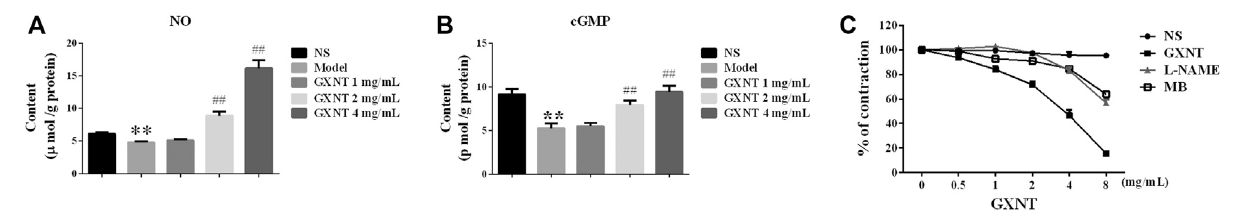
FIGURE 3 | GXNT promoted nitric oxide (NO) production in endothelium-intact vascular rings and further activated the soluble guanylate cyclase (sGC) – cyclic guanosine monophosphate (cGMP) expression. NO (A) and cGMP (B) contents in endothelium-intact vascular rings after GXNT treatment. After precontraction with 10 − 6 M PE, rings with intact endothelium were incubated with 1, 2, and 4 mg/ml GXNT for 45 min and immediately collected for homogenization. Before testing with an ELISAkit, homogenate supernatants werecentrifuged at3,000 rpmfor10 min. Themodel indicates treatment withPEwithoutGXNT,NSindicates treatmentwith onlynormalsaline. (C) ImpactofGXNTonNOsynthesisandGCinendothelium-intactvascularrings.AorticringswerepreincubatedwiththeNOSsynthaseinhibitorNw- nitro-L-argininemethyl ester(L-NAME) (10 − 4 M)and guanylate cyclaseinhibitor methylthionine chloride (MB)(10 − 5 M) for30 min. Afterpretreatment with10 − 6 MPE,the rings were bathed in GXNT for 30 min. The change in tension was noted and quanti fi ed by the ratio of tension after GXNT and inhibitor administration to the contraction tension with PE. ( **p < 0.01 compared with the NS group, ## p < 0.01 compared with the model group). Results are presented as the mean ± SD of the data obtained in three independent experiments with six duplicate